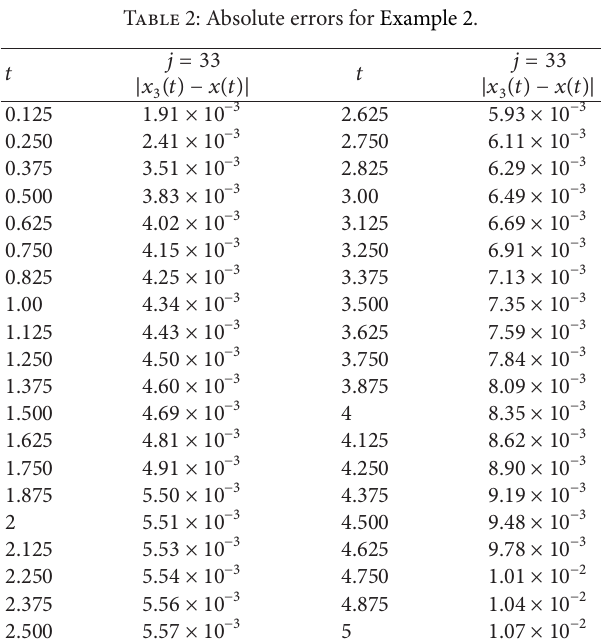
Table 2: Absolute errors for Example